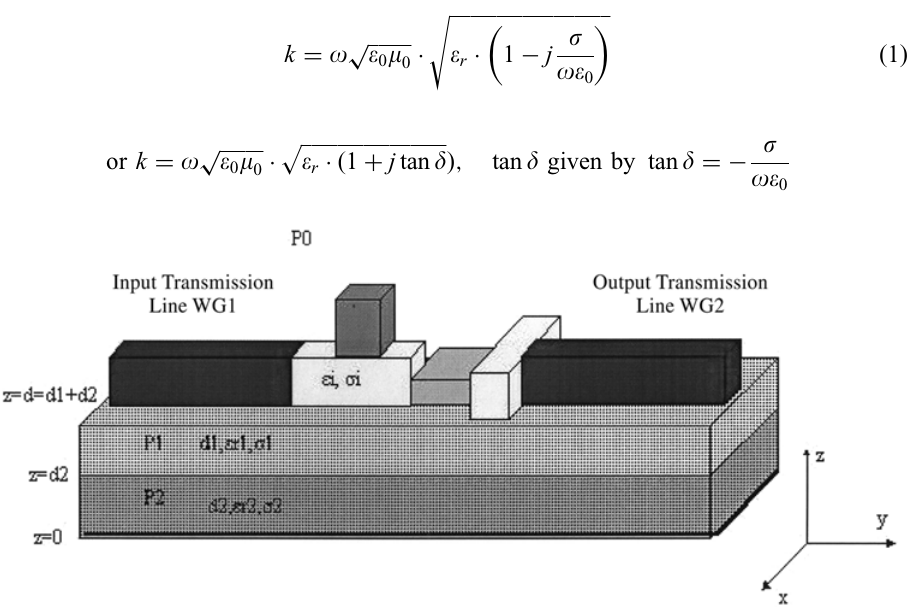
FIGURE 1 General circuit